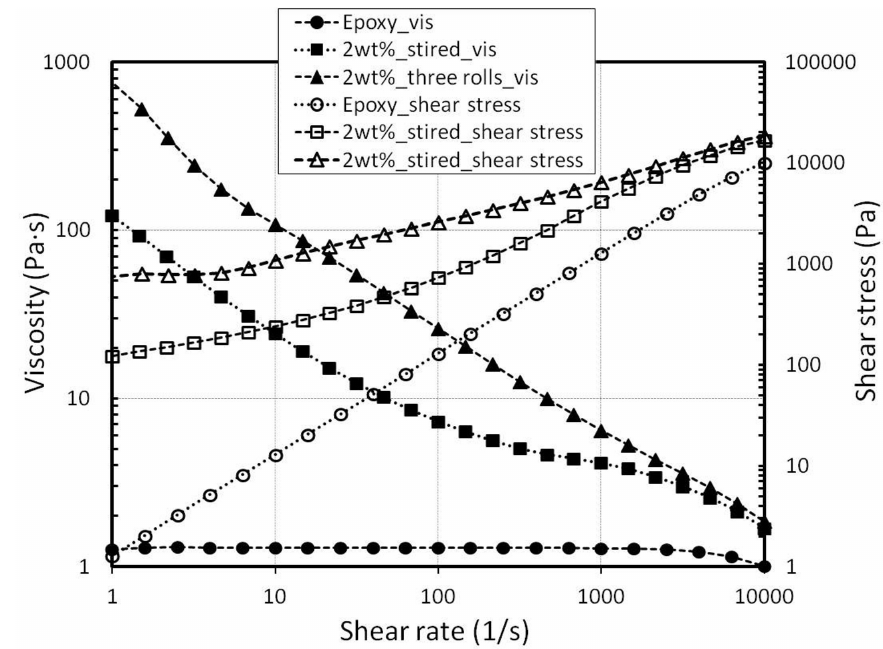
Figure 7. Viscosity of the dispersions at different mixing